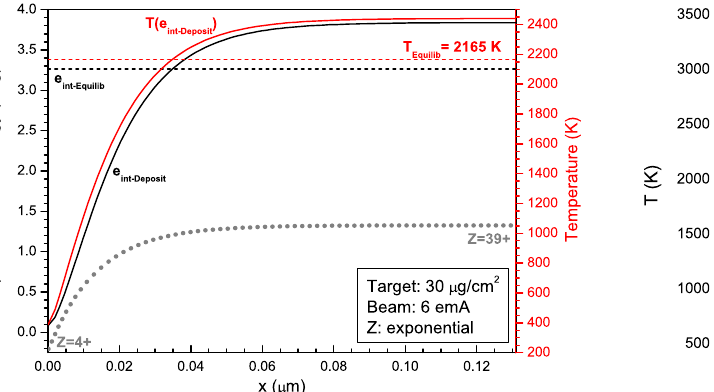
FIG. 11. Same as in Fig. 3, but using beam current of 18